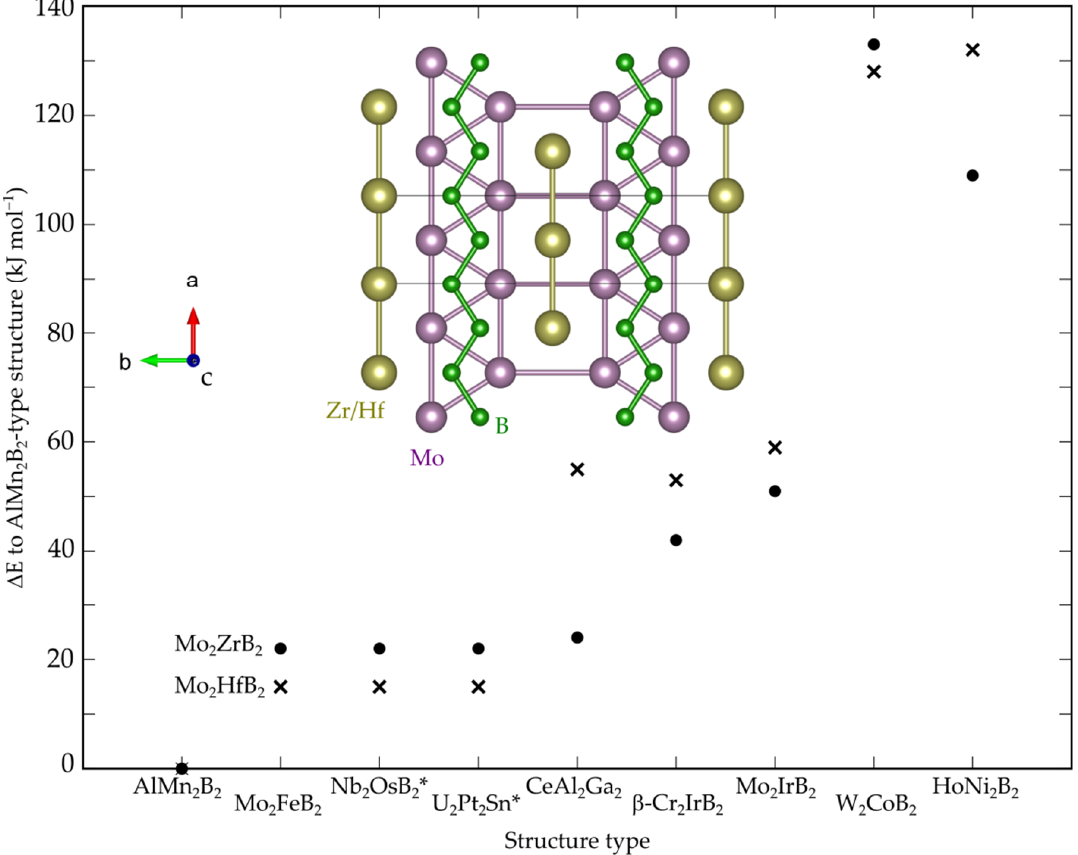
Figure 1. The calculated energy di ff erences of the phases Mo 2 ZrB 2 and Mo 2 HfB 2 per formula unit with the di ff erent types of crystal structures. *: Unstable crystal structures, which turn to the Mo 2 FeB 2 type during the structural relaxation.